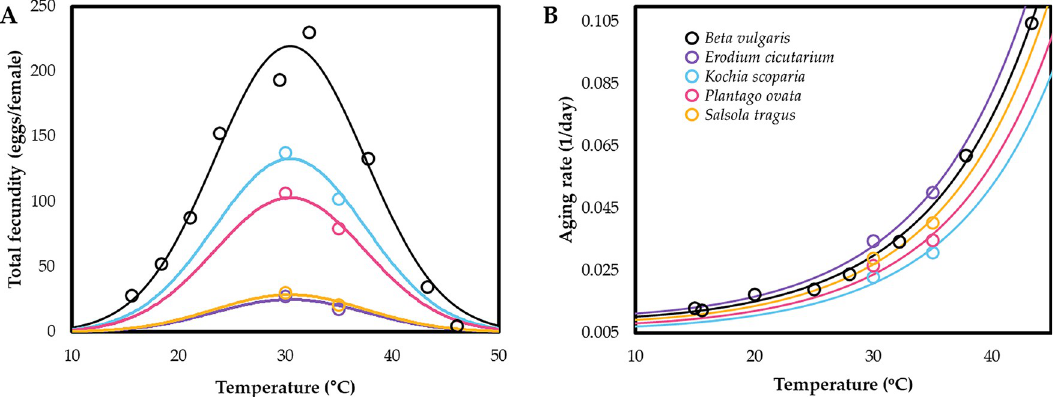
Fig 2. Temperature-dependent (A) total fecundity and (B) aging rate (1/mean longevity) models of female beet leafhoppers on five host plant species. The data points for sugar beet were obtained from the published paper, Harries and Douglass (1948)